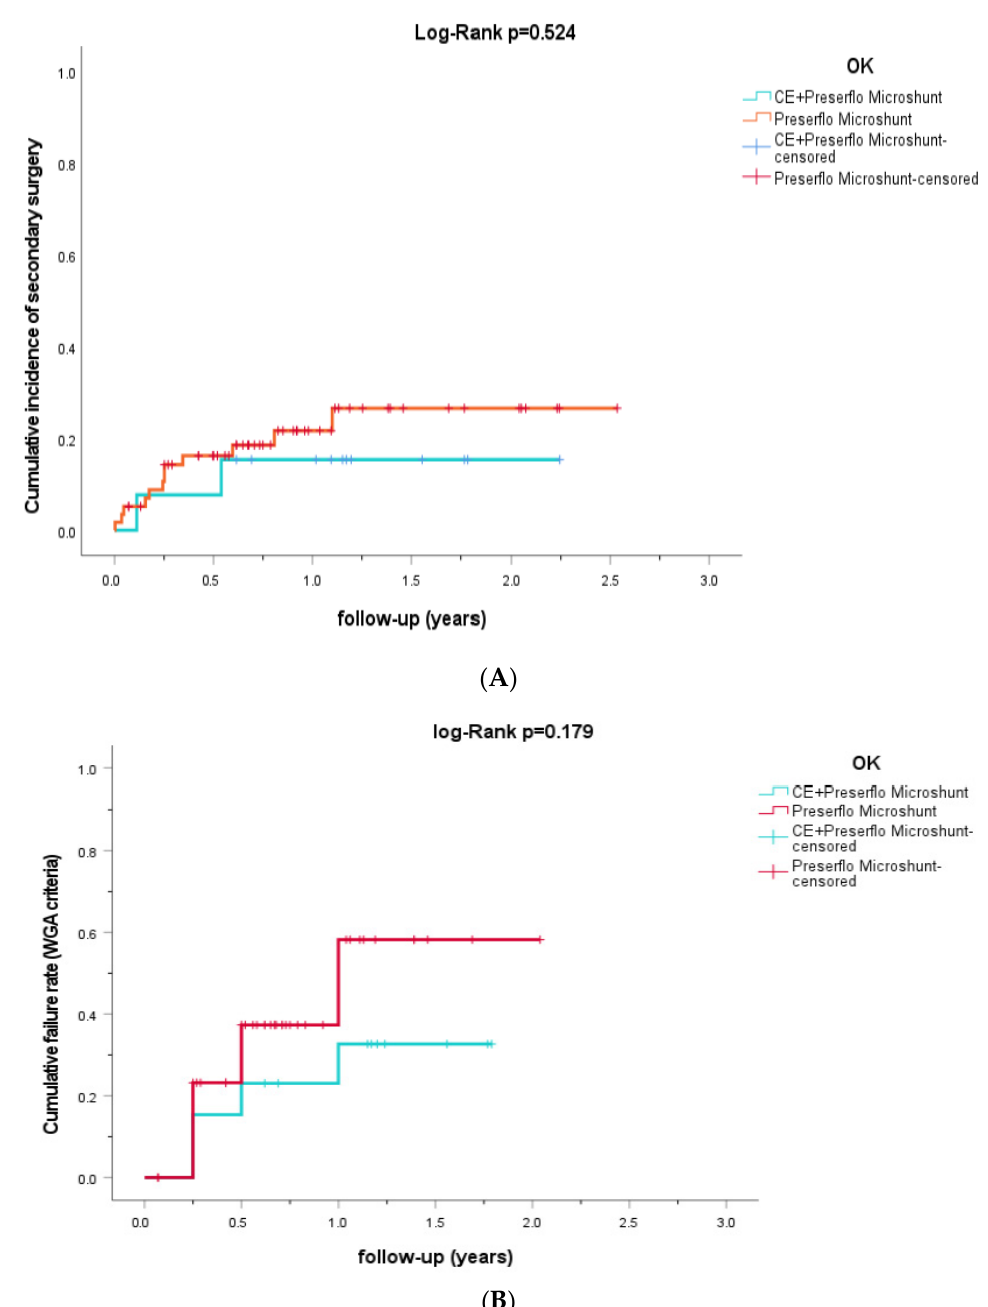
Figure 1. ( A , B ) Mean intraocular pressure (IOP, lines) and mean number of IOP-lowering medica- tion (bars) for PRESERFLO as a standalone procedure vs. as a cataract-combined procedure ( A ) and all Preserflo surgeries (including combined procedures) vs. secondary surgeries (all revised Preserflo implants) ( B ). The “last” time interval had a median (interquartile range) follow-up of 1.02 (0.68–1.46) years. The vertical lines represent the standard deviation (SD). IOP = intraocular pres- sure; CE = cataract extraction.